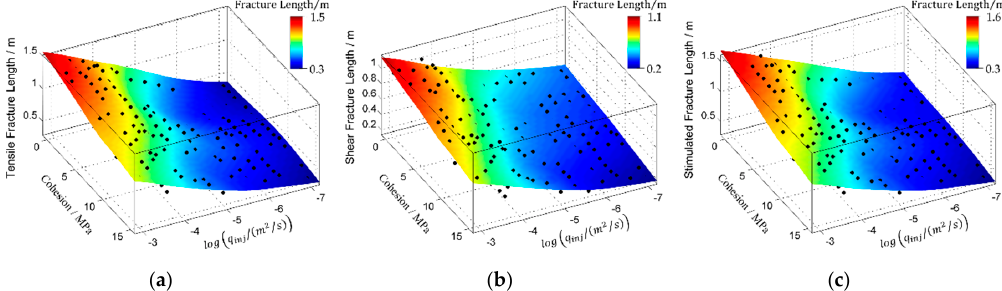
Figure 9. Variations of the fracture lengths with injection rate and the cohesion of pre-existing fractures. ( a ) The variation of the tensile fracture length; ( b ) The variation of the shear fracture length; ( c ) The variation of the stimulated fracture length, i.e., the length of the fractures that are either tensile or shear fractures. In these figures, each black point represents the result of a simulation. The colored surfaces represent the smoothed results.